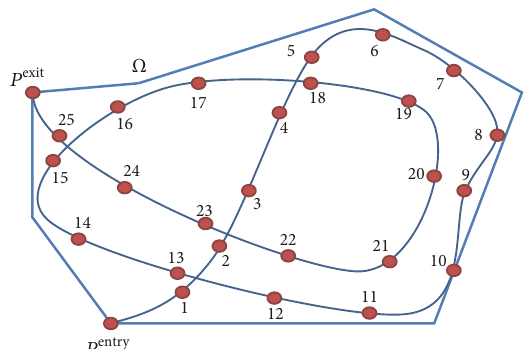
Figure 1: Problem of generating a trajectory that maximizes the area